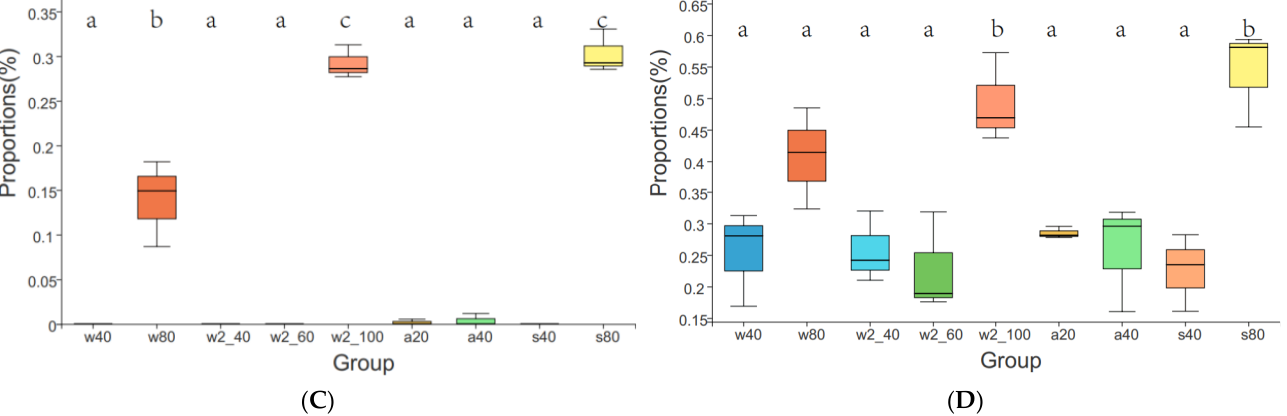
Figure 5. FAPROTAX analysis of variations in functional groups of bacteria in black soil. ( A ) Differential abundance of bacterial nitrification among sample groups (Table S4). ( B ) Differential abundance of ureolysis, a dominant nitrogen mineralization process. ( C ) Differential abundance of nitrite ammonification (DNRA). ( D ) Differential abundance of nitrate respiration (NRA). Boxes represent 25 – 75% of the data, middle lines the median, and the two lines above and below the box represent the maximum and minimum values respectively. Kruskal-Wallis H rank sum test was used in the multi-group comparison; false discovery rate (FDR) was used for the multiple test correction, and Tukey-kramer method was used as the post-hoc test of pairwise comparison. Means that do not share a letter are significantly different.